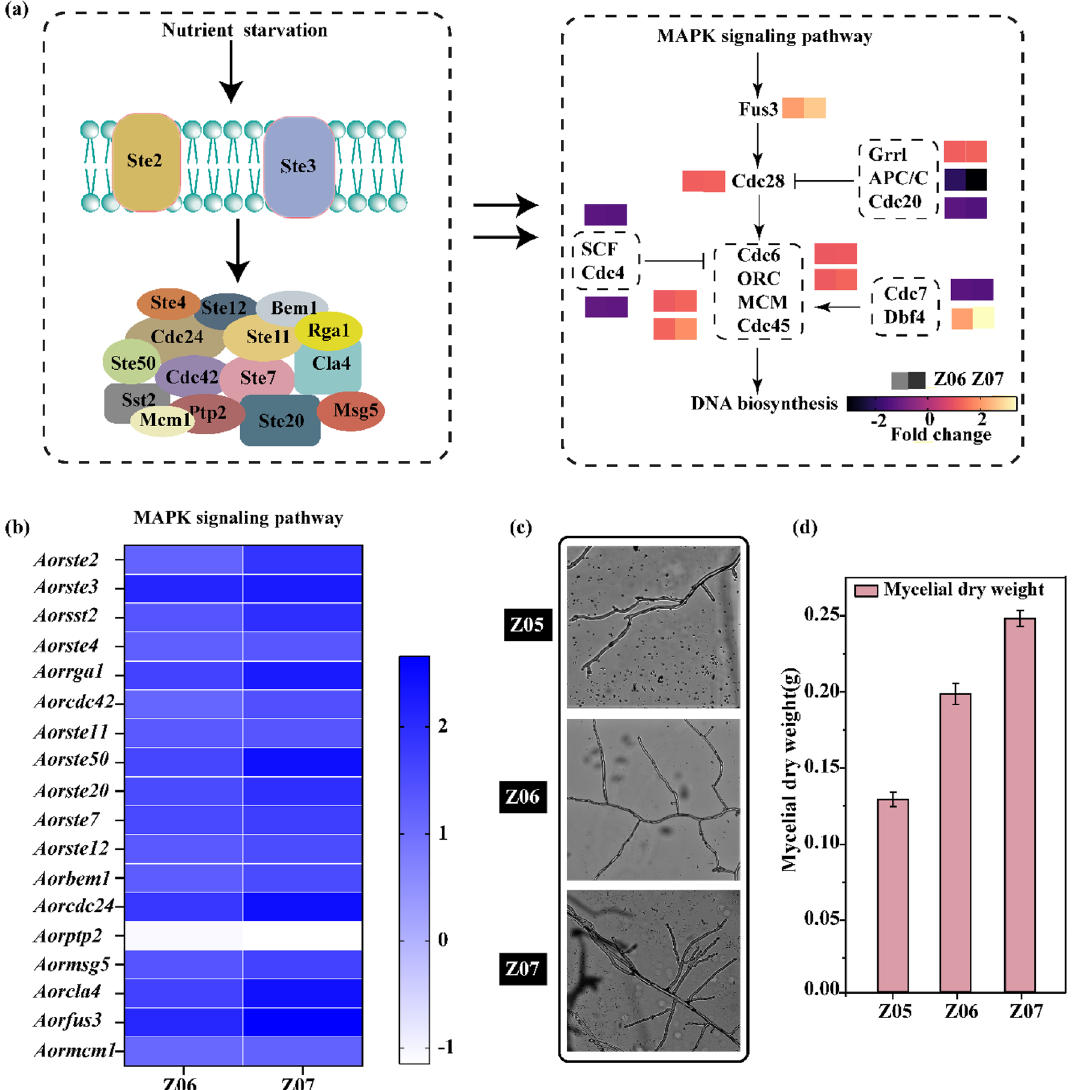
Fig. 4 Transcriptome analysis and morphological characterization to clarify the mechanism of hyphal branching formation in Aspergillus oryzae . a Diagram of the mechanism of hyphal branching formation. b Heat map of the hyphal branching formation mechanism following comparison between the strain Z06 and Z07. c The morphological characteristics of hyphal branching of the strain Z05, Z06 and Z07 under light microscopy. d Mycelial dry weight of the strain Z05, Z06 and Z07. All data are presented as mean values from three independent experiments. Error bars indicate the standard